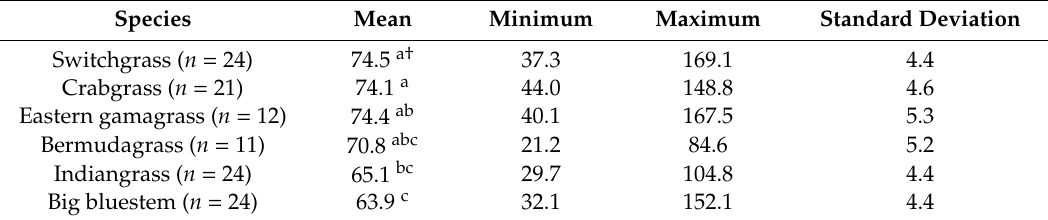
Table 4. Least square means of iWUE ( µ mol CO 2 mol H 2 O − 1 ) by species during field experiment